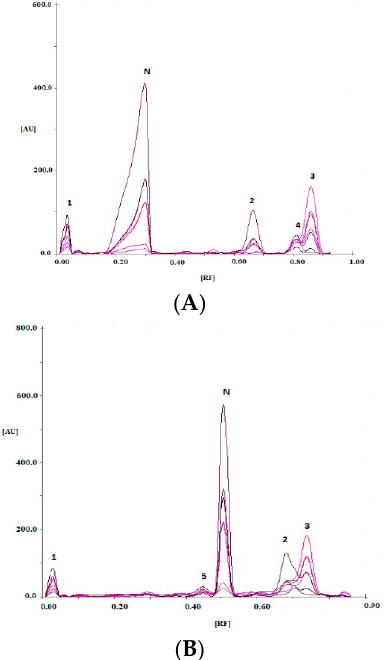
Figure 7. Densitogram of naproxen (N) in hydrogen peroxide (VI), which was irradiated (254 nm) for 10 h and analyzed using: ( A ) TOL-ACE-CHL; 2:5:12, v/v/v; and ( B ) AcOH-Hex-ACE, 0.10:10:10 v/v/v as mobile phases, where: 1, 2, 3, 4, 5—degradation products of naproxen; and 2 was identified as naproxen ethyl ester.